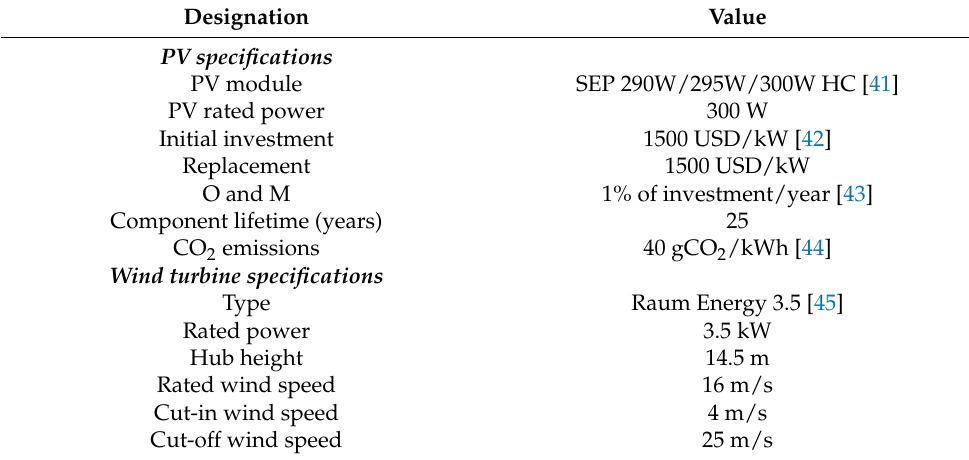
Table 3. Parameter specifications used for